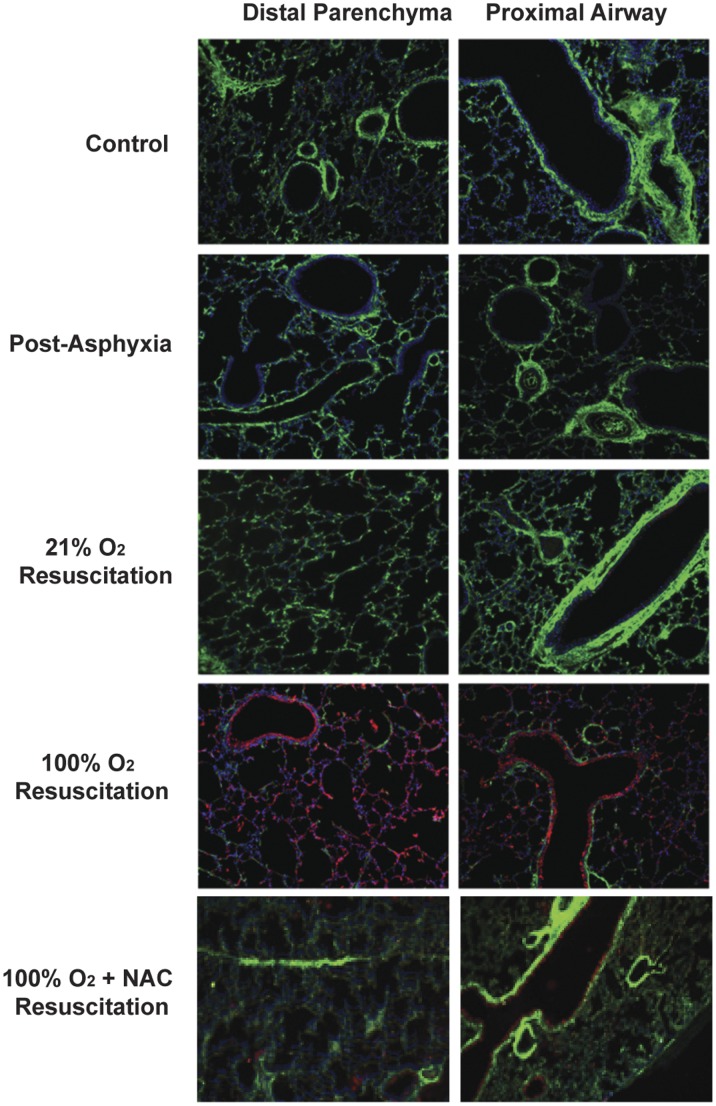
Dual immunostaining for 3-nitrotyrosine and HA.Formalin-fixed, paraffin-embedded sections of inflated lungs were processed for dual label immunofluorescence using an antibody specific for 3-NT to localize peroxynitrite (red), and a biotinylated HA-binding probe to localize HA (green), with DAPI to label nuclei (blue). Control animals had abundant staining for HA in the sub-epithelial matrix around bronchiolar smooth muscle and on the endothelium of blood vessels, with less evident staining in the distal parenchyma and alveoli. At the end of asphyxia, there appeared to be a slight, but generalized decrease in HA staining in both the proximal airway as well as the distal parenchyma. Animals examined 150 minutes after 21% O2 resuscitation had HA staining that was not distinguishable from control animals, and had no staining for 3-NT. However, 150 minutes after 100% O2 exposure, little to no HA staining and an increase in 3-NT staining was observed throughout the lung. Animals resuscitated with 100% O2 and given NAC had little 3-NT staining and had HA staining similar to that of animals resuscitated with 21% O2.